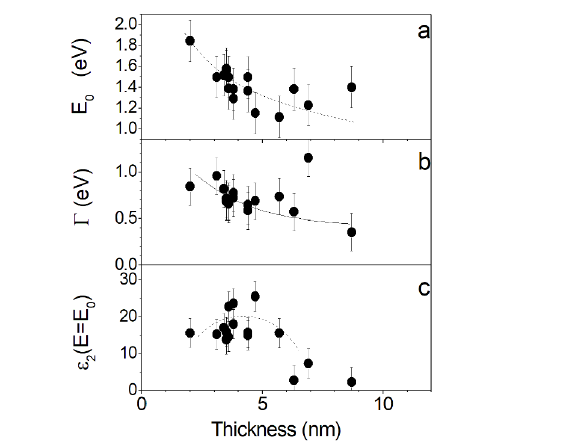
Figure 4. Energy of the oscillator describing the LSP (a); broad- ening of the oscillator (b); peak value of the associated contribu- tion to the imaginary part of the dielectric constant (c). The lines are a guide to the eye.